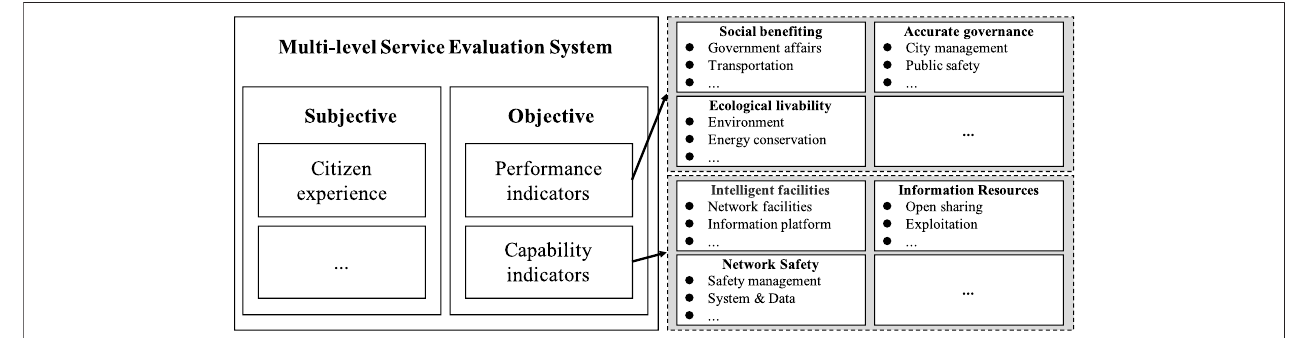
FIGURE 2 | An illustration of the multi-level service evaluation system. The bold items in the right box indicate various primary indicators, each of which contains multiple secondary indicators.